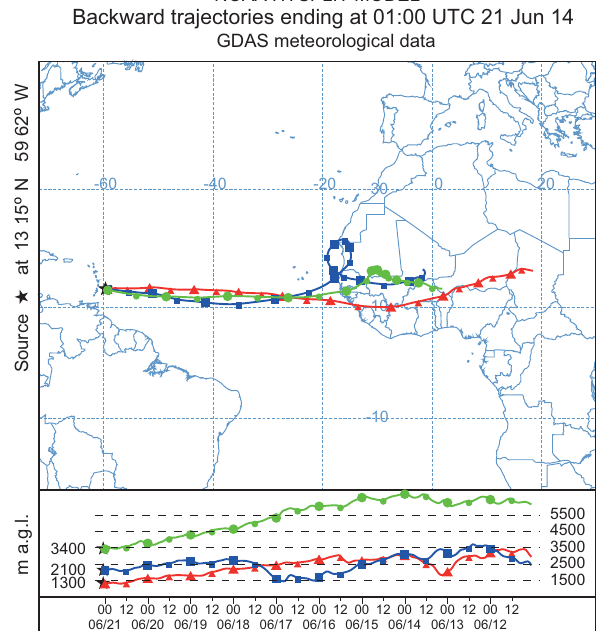
Figure 6. Ten-day HYSPLIT backward trajectories for 21 June 2014, 01:00UTC (HYSPLIT, 2016). The observed dust left the African continent 4–5 days before arrival over Barbados. Indicated arrival heights are 1.3km (red), 2.1km (blue), and 3.4km